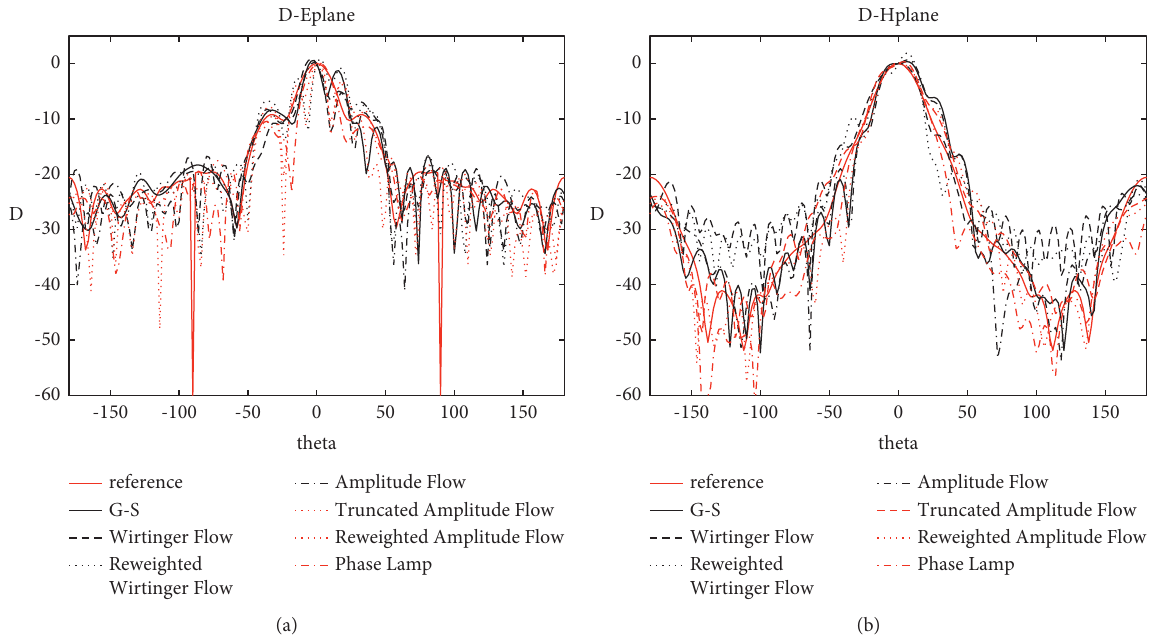
Figure 20: The obtained radiation pattern of horn antenna by adopting other phase recovery algorithms. (a) E-plane. (b) H-plane.